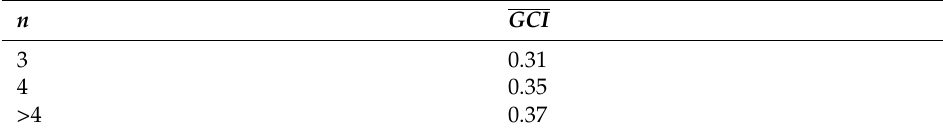
Table 3. Thresholds of GCI